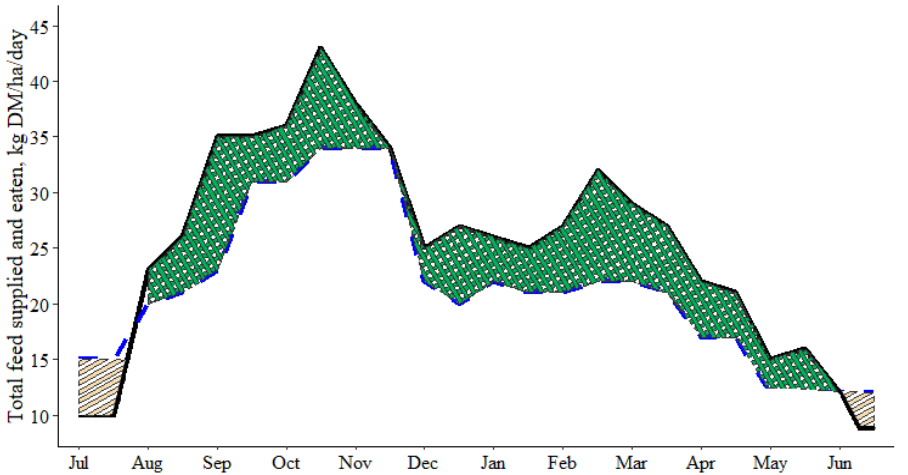
Figure 5. Utilizable pasture supplied (black line) and eaten by the sheep activity (blue dashed line, which includes silage) in the optimized farm system throughout the year. The excess available herbage (i.e., neither utilized nor processed for silage) is indicated by the green shaded area and the deficient available herbage (i.e., where sheep requirements were greater than the available pasture) which was supplemented with silage is indicated by the striped area.